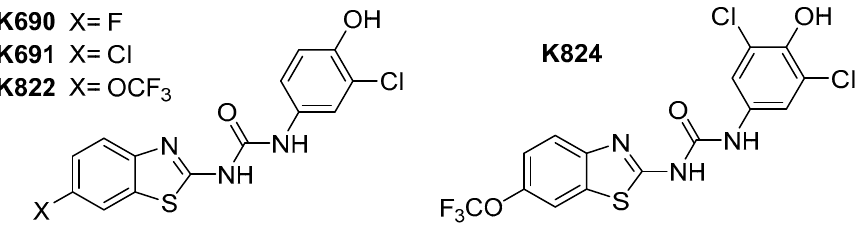
Figure 1. Structure of previously identified benzothiazolylurea inhibitors.